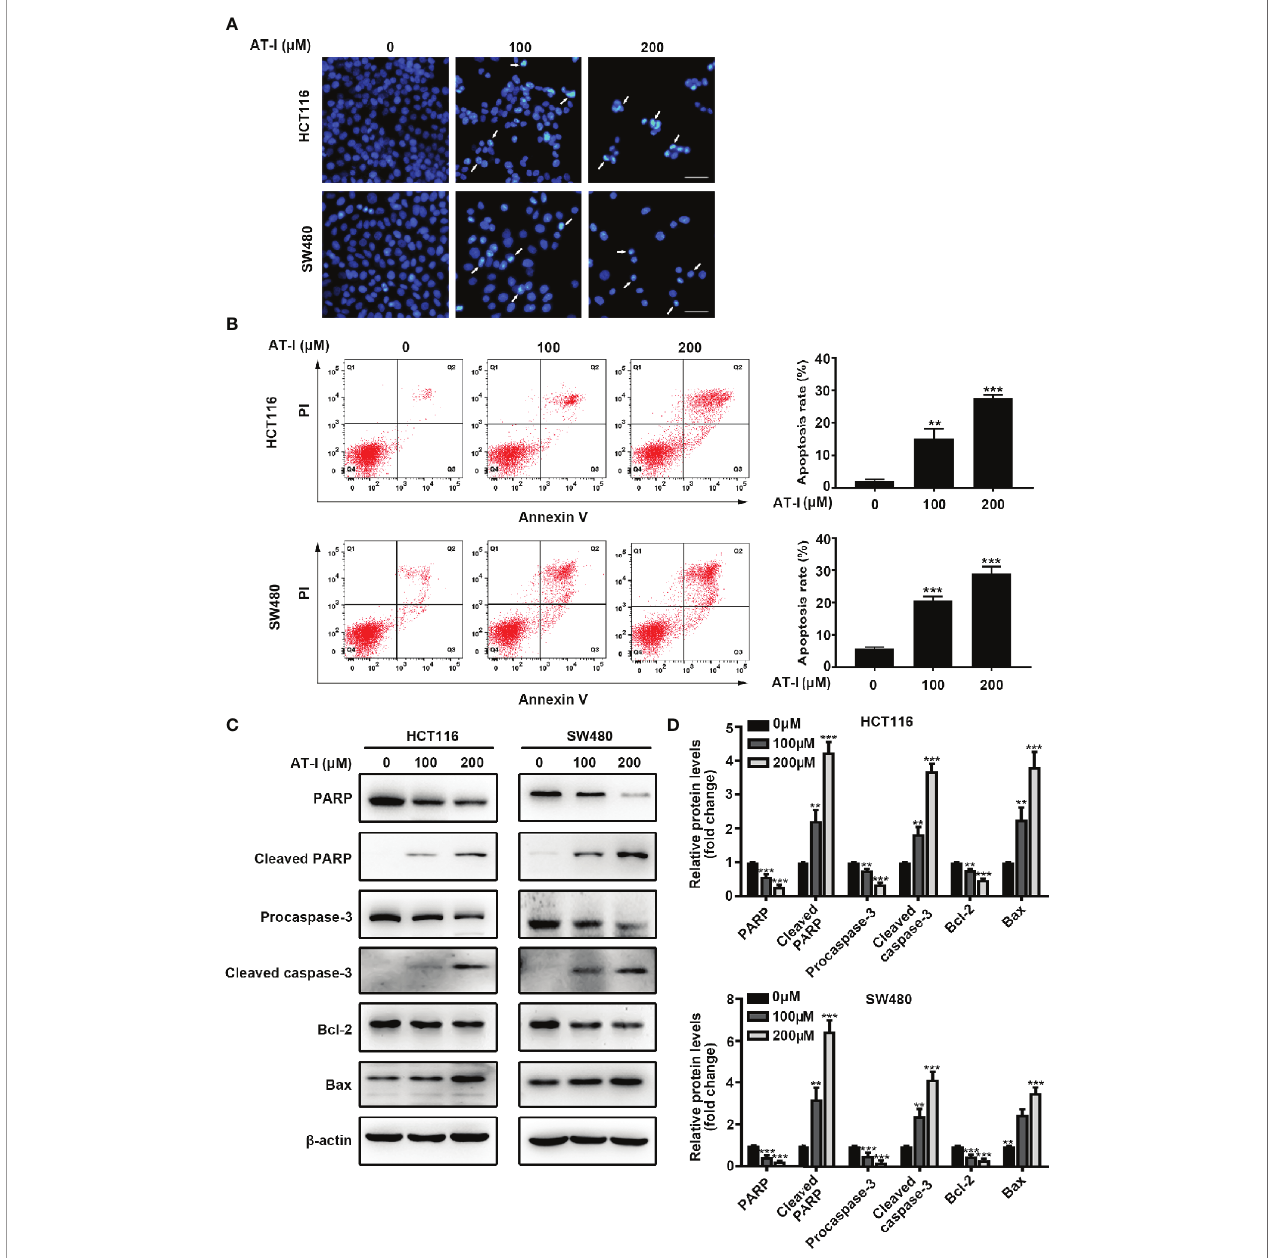
FIGURE 2 | AT-I induces apoptosis of CRC cells. (A) DAPI staining of CRC cells treated using the indicated concentrations of AT-I for 24 h. White arrows indicate a nuclear morphological change in the treated cells. Scale bar = 100 m m. (B) Analysis of apoptosis using Annexin V-FITC/PI double-staining of CRC cells treated with the indicated concentrations of AT-I for 24 h. Apoptotic ratios represent the percentage of CRC cells in early apoptosis (PI negative/Annexin V-FITC positive) and late apoptosis (double-positive staining). Representative images of the results are shown in the left panel, and the results of the quantitative analysis are shown in the right panel. (C) Western blot analysis performed to detect the protein expression levels of PARP, cleaved PARP, procaspase-3, cleaved caspase-3, Bcl-2, and Bax in CRC cells after treatment with AT-I for 24 h. (D) The relative protein levels are normalized to those of b -actin, and these are shown as fold changes relative to the control group levels. ** p < 0.01 and *** p < 0.001 compared with the control group without any